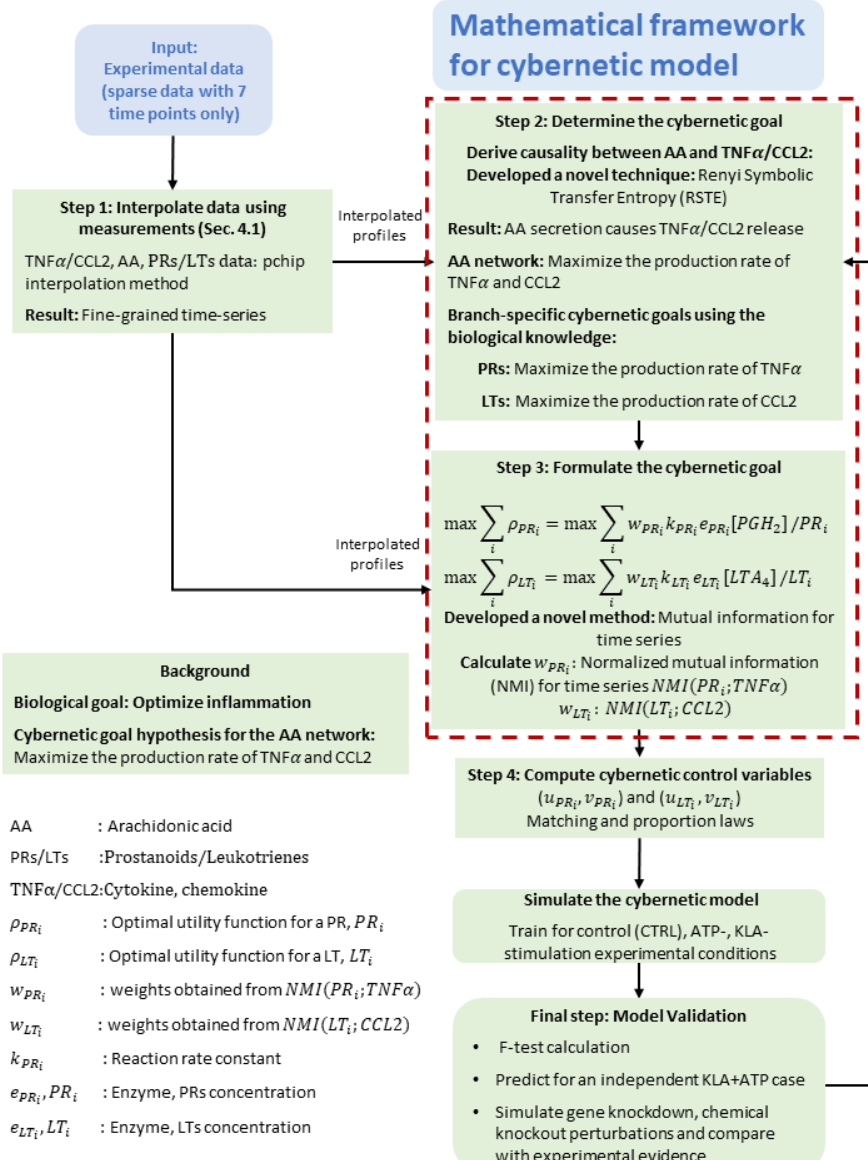
Figure 2. The mathematical framework of the cybernetic model employed to study the eicosanoid metabolism in the presence of the cytokine TNF α and chemokine CCL2. The experimental data is available for eicosanoids and signaling molecules for four different experimental conditions (CTRL, ATP, KLA, and KLA+ATP stimulation) at the LIPID MAPS website. The measurements available for PRs and LTs (lipidomic data) and TNF α (proteomic data), and CCL2 (transcriptomic data) at seven time points (0.25, 0.5, 1, 2, 4, 8, and 20 h). We employed the Python function pchip to generate data at intermediate time points. We derived causality for AA with TNF α and AA with CCL2 to justify the cybernetic goal. We used NMI to mathematically formulate the goal expressed as ρ PR , ρ LT and computed cybernetic control variables using the goal. We trained the model for CTRL, ATP, and KLA experimental conditions. The final step was to validate the model by predicting an independent experimental condition of KLA+ATP stimulation, and performing F-Test. We also compared the simulated profiles of gene knockdown perturbation scenarios with the available experimental evidence.